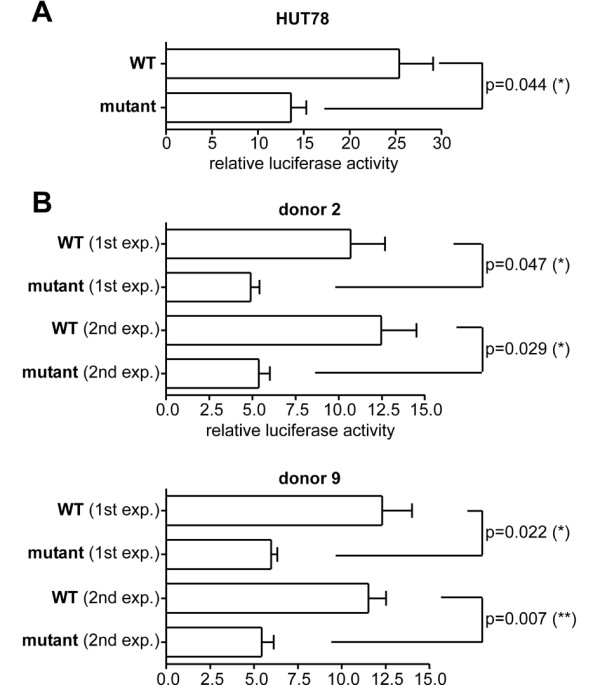
Relative luciferase activity of the wild type promoter (WT) and a promoter construct bearing the -60 C/T mutation in homozygosis. (A): relative luciferase activity in HUT78 cells following transfection of the promoter constructs by electroporation. Data shown is representative of three independent experiments. (B): relative luciferase activity in primary T-cells that were transfected with the promoter constructs using Amaxa transfection technology. Two independent experiments (exp.) were performed. In each experiment primary T-cells from 13 donors were used. Shown are results from donor #2 and donor #9. No differences between WT and mutant promoter activity were observed in the remaining 11 donors. Error bars represent the SEM of triplicates. Statistic analysis was performed applying unpaired t-test. Values < 0.05 were considered significant (* = p < 0.05, ** = p < 0.01).